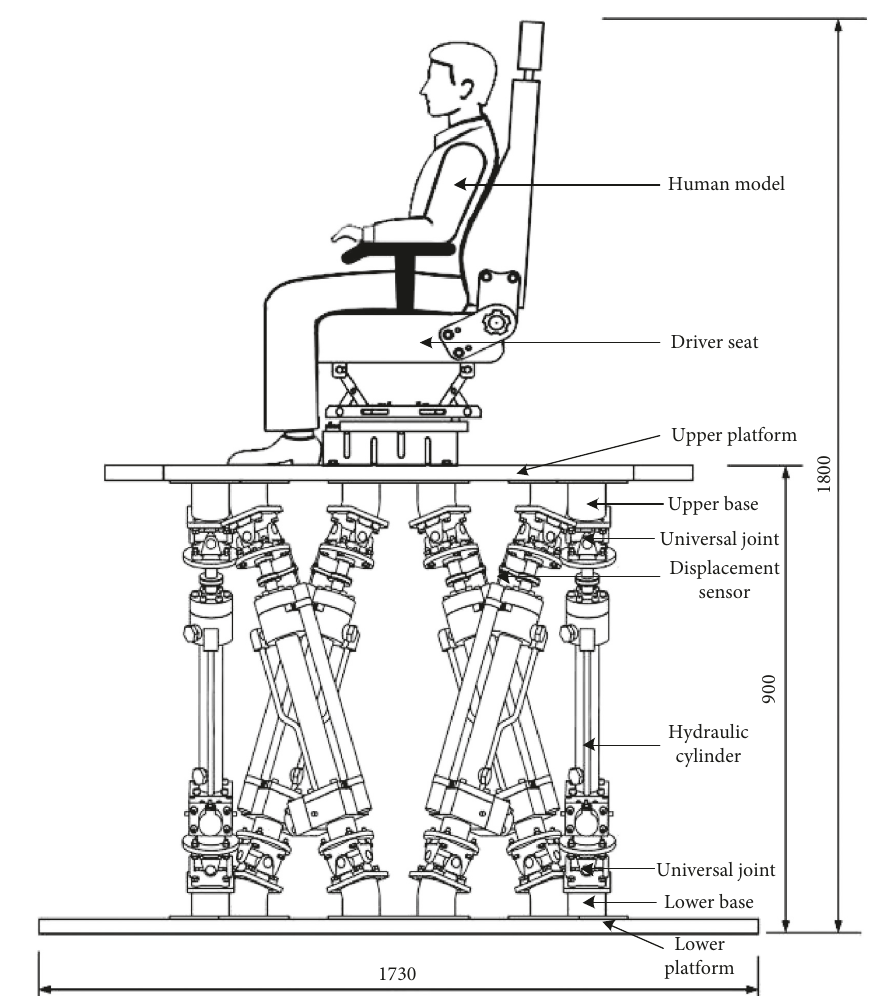
Figure 1: Structure of the vibration representation platform. Table 1: Technical index of the vibration representation